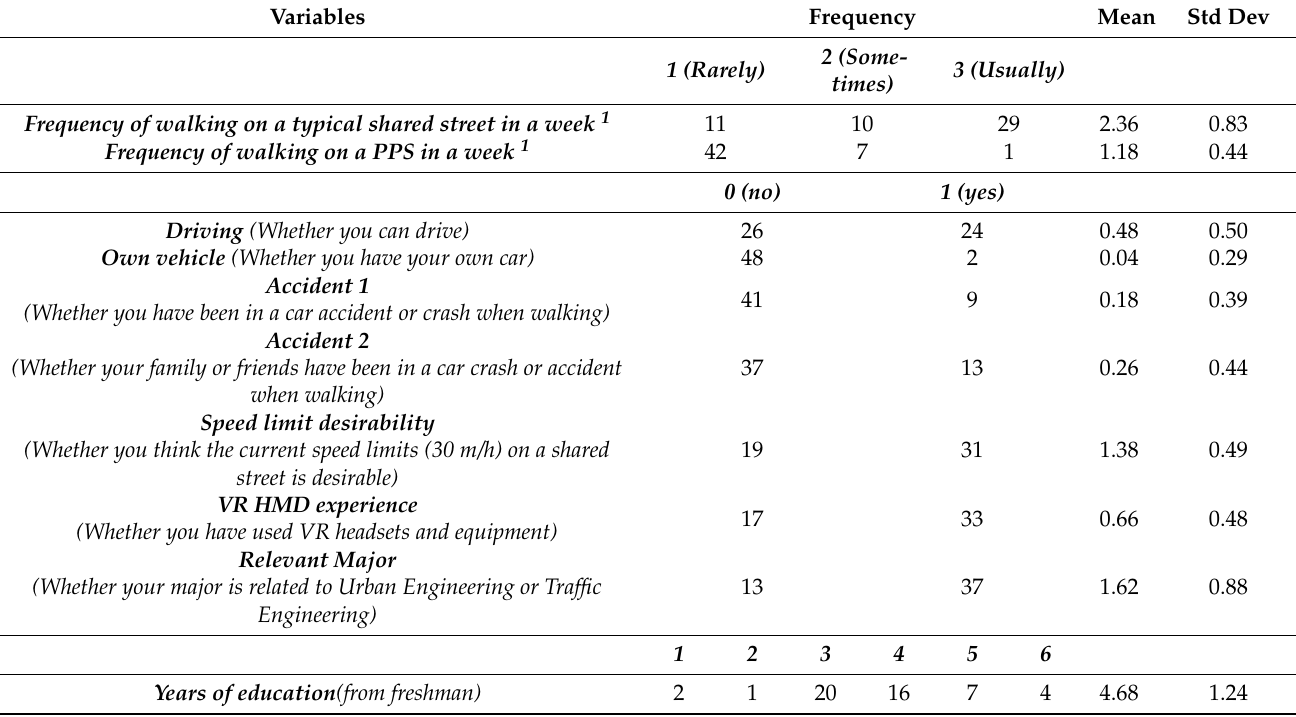
Table 3. Basic characteristics of the